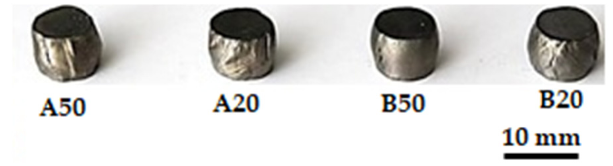
Figure 8. The samples after compression test.